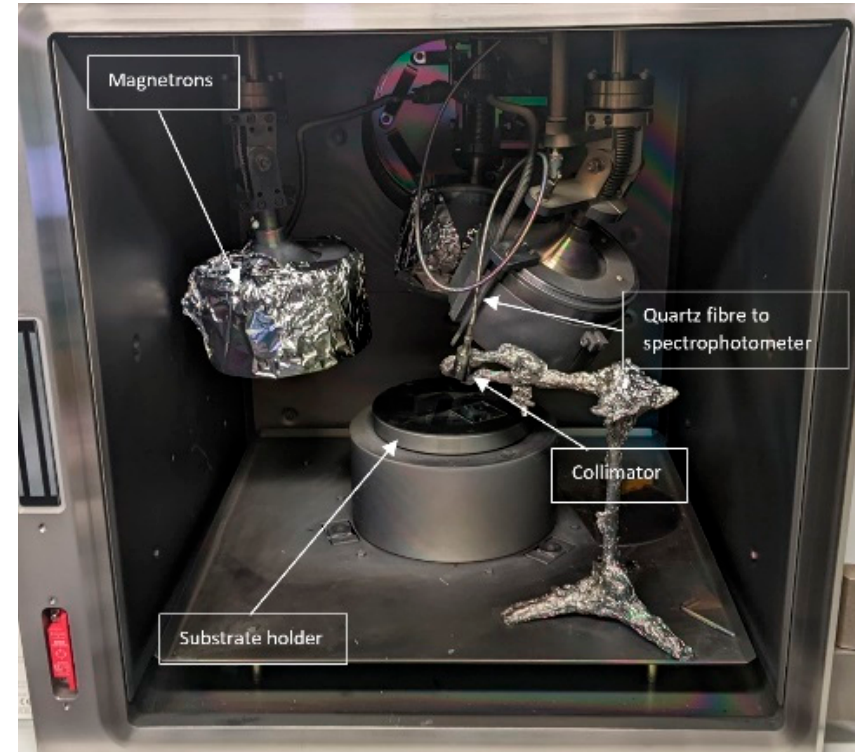
Figure 3. The sputtering chamber, illustrating the position of the collimator.